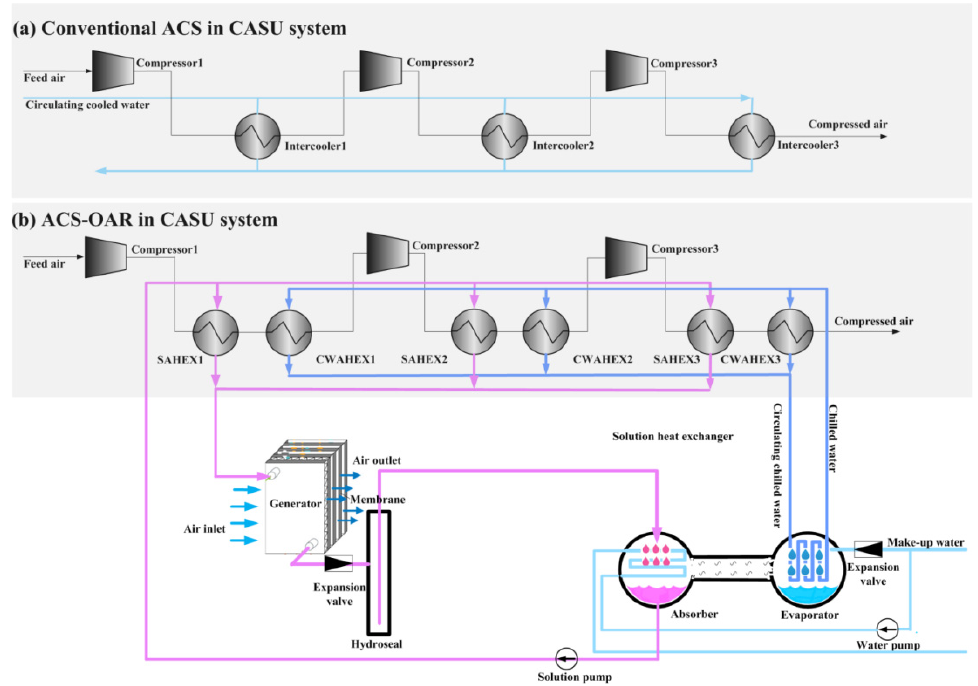
Figure 2. ( a ) Schematic of a feed air compression section with conventional cooling system; ( b ) schematic of a cryogenic air separation unit coupled with an open-cycle absorption